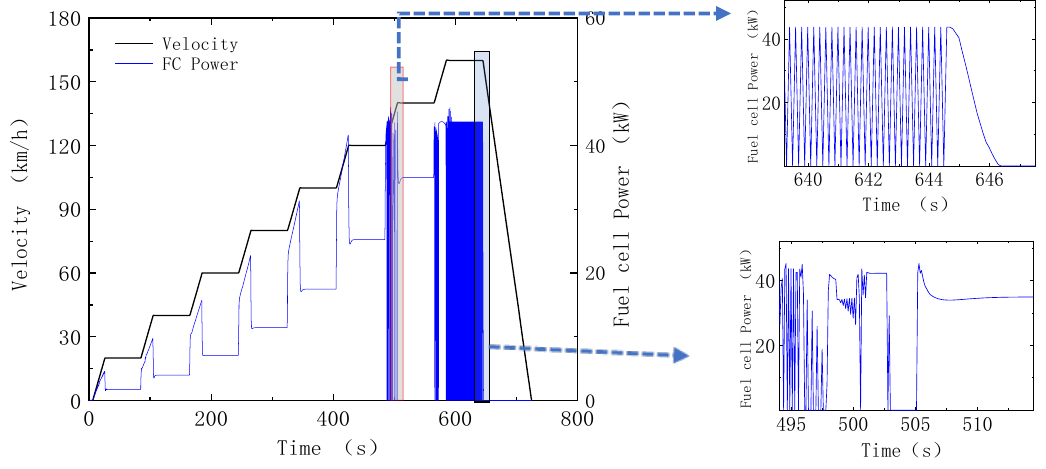
Figure 14. Changes in fuel-cell power of the FCV in cruising mode.